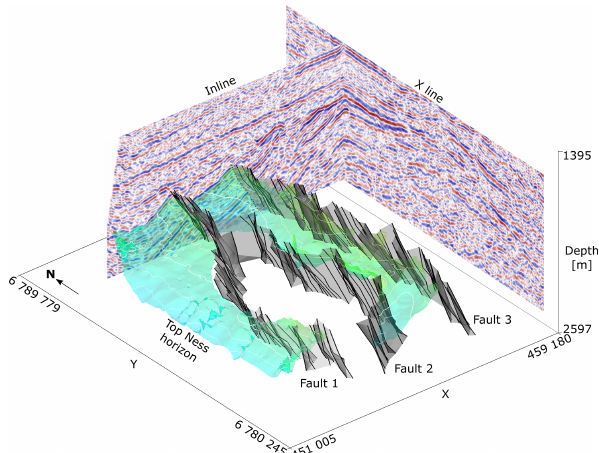
Figure 2. Example interpretation from a single student, showing the three major faults considered in our study as well as part of the Top Ness horizon interpretation. Base Cretaceous Unconformity (BCU) and additional faults towards the east are hidden for better visualization of the key